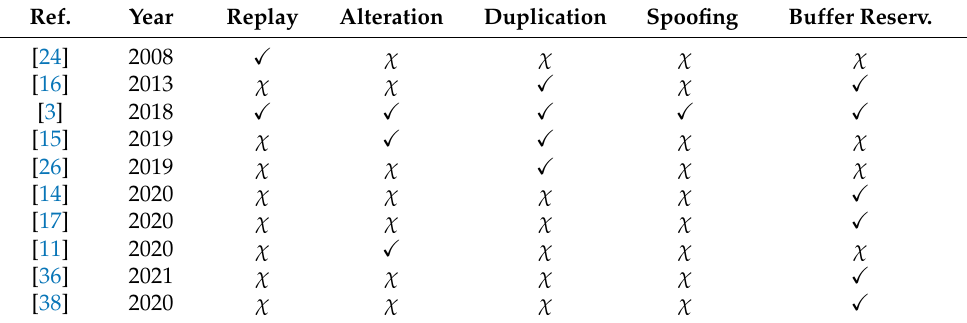
Table 2. Comparative analysis of fragmentation attack countermeasures.